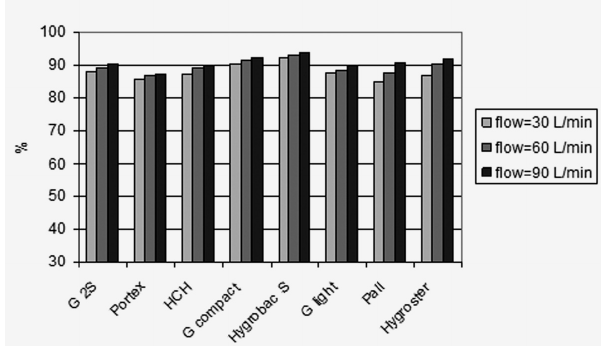
Figure 4 - Effect of flow rates (30, 60 and 90 L/min) with changing %RAH. %RAH did not depend heavily on flow rates, and we failed to identify any dif- ferences between the HME models in terms of humidification